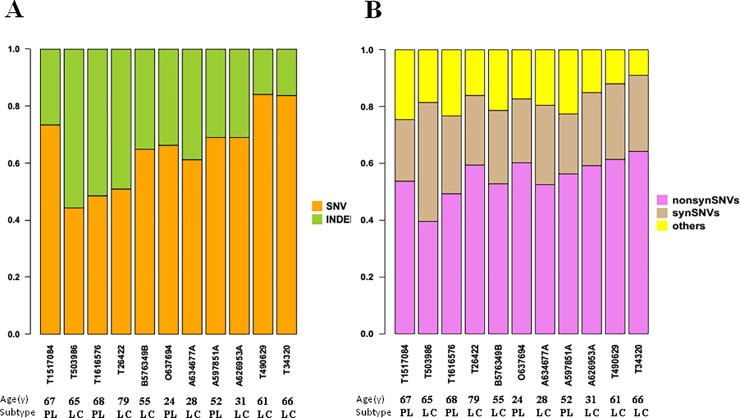
An overview of the data analysis strategy for single-nucleotide variations (SNVs) and indels shown by whole-exome sequencing.On average, we identified 220 (range, 126–358) somatically acquired point mutations per case. Of these, an average of 168 (range, 105–252) were non-synonymous and 81 (range, 52–149) were synonymous. Thus, the ratio of non-synonymous to synonymous was 2.08 (0.95–2.67) mutations per Mb.